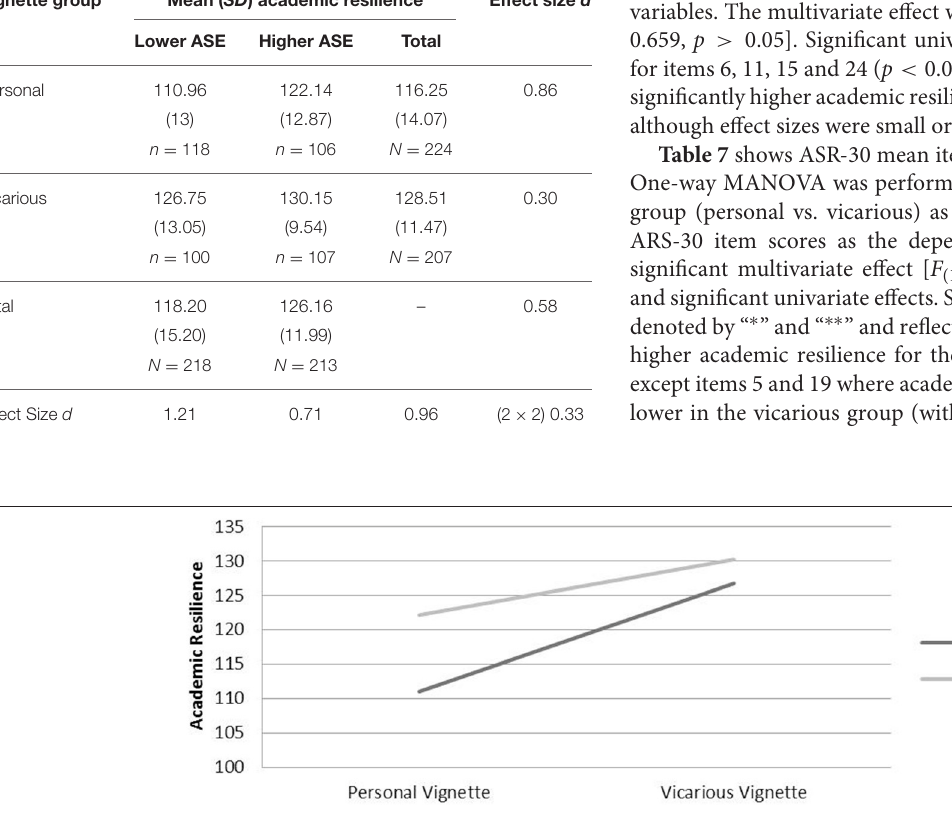
FIGURE 1 | Mean academic resilience by ASE group vignette